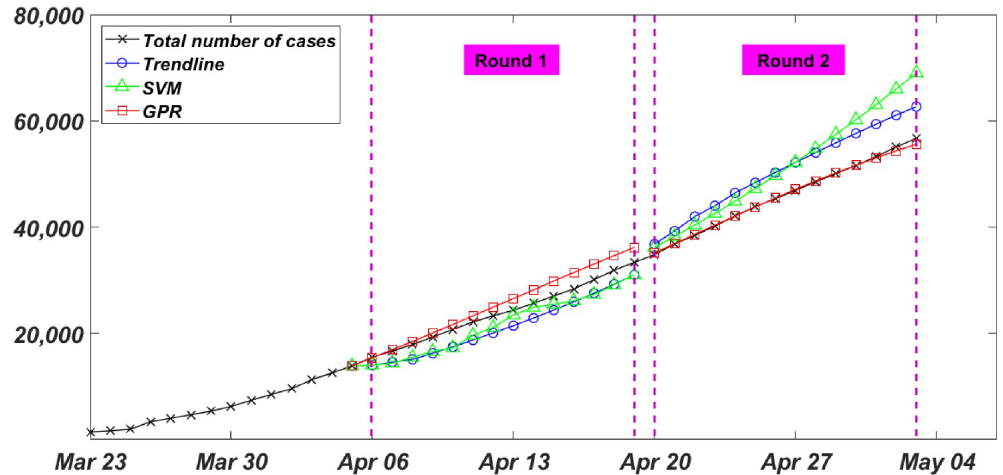
Fig 4. Rounds 1 and 2 of the bi-weekly total number of infected COVID-19 cases in Canada.